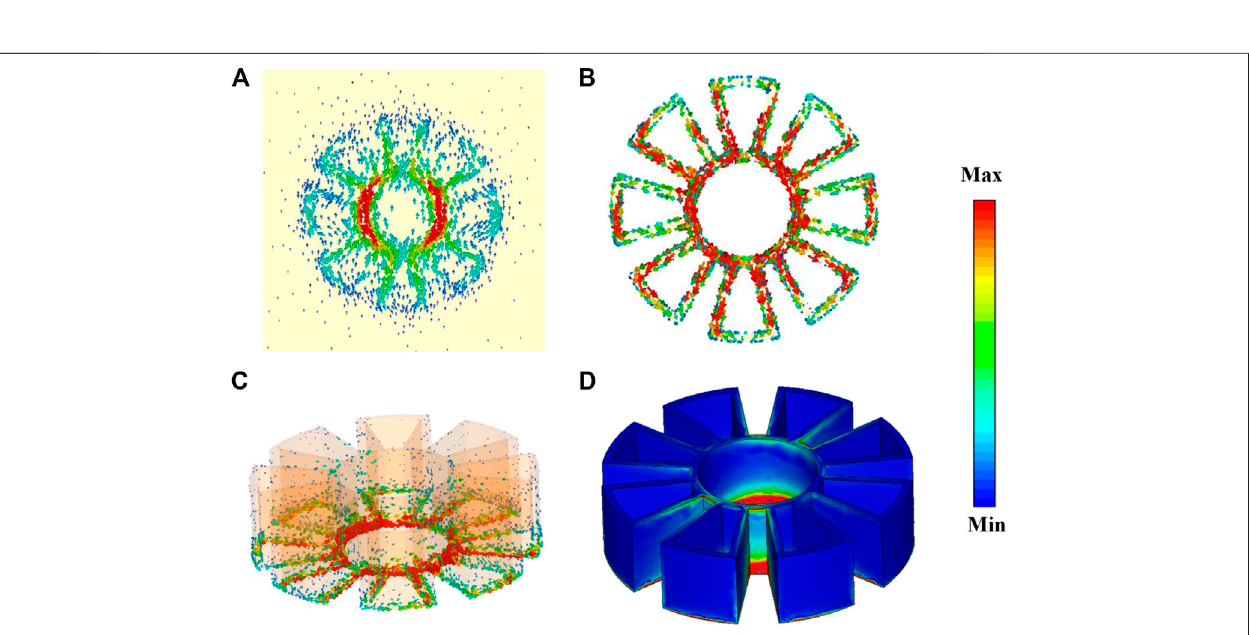
FIGURE 4 | Simulated surface current distribution on (A) bottom ground layer (B) 3D resonator on top view, and (C) 3D resonator on perspective view, and (D) distribution of the power loss on the 3D resonator.